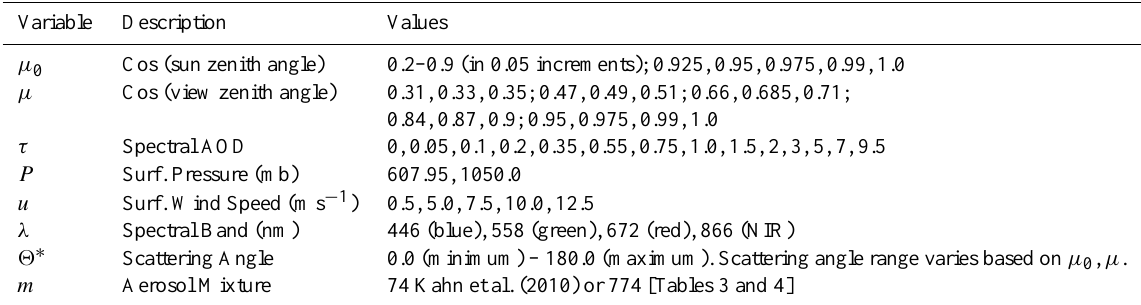
Table 1. Dimensions of the MISR RA look-up table (LUT), representing the SMART output. Variable